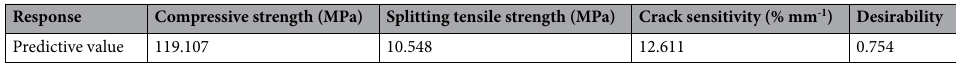
Table 7. Optimal solution of the prediction